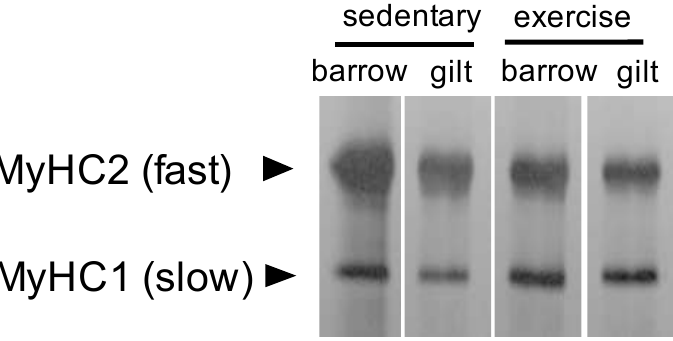
Figure 1. Separation of myosin heavy chain (MyHC) isoforms of the porcine longissimus dorsi (LD) muscles from sedentary or exercising barrows and gilts by using SDS-PAGE.